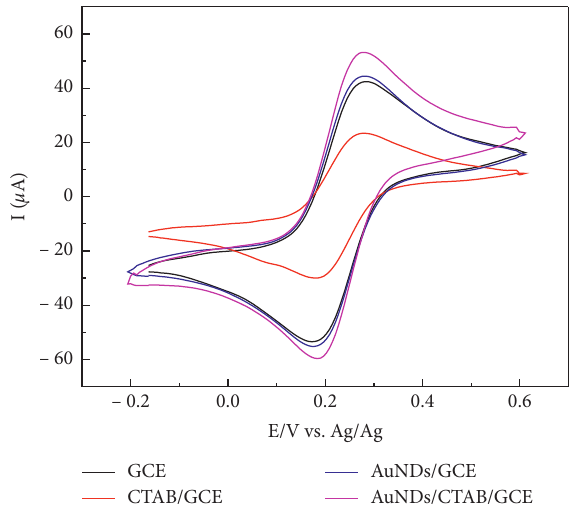
Figure 3: CVs of GCE, CTAB/GCE, AuNDs/GCE, and AuNDs/ CTAB/GCE in 5mM Fe(CN) 63 − and 0.2 M PBS, from − 0.2 to 0.6V versus